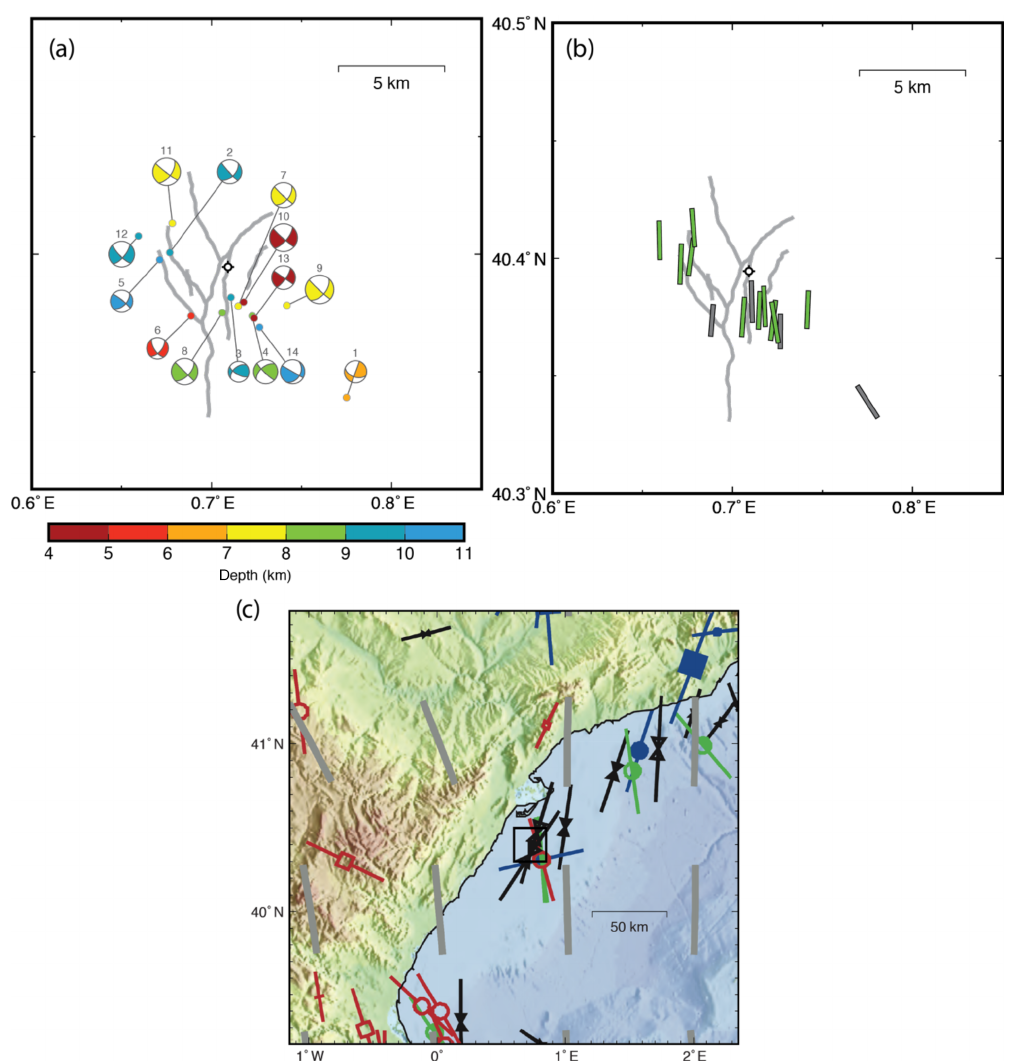
Figure 6. Focal mechanisms obtained in this study. (a) Nodal planes projected in the lower hemisphere of the focal sphere. Colored quadrants correspond to compression, and the color represents focal depth according to the legend. Numbers above each beach ball correspond to the solution listed in Table 3. Thick grey lines indicate the traces of main faults in the area at 1700m depth (Geostock, 2010). (b) Orientation of the P axes of the mechanisms shown in panel (a) . Green indicates predominantly strike-slip mechanism, and grey mixed type. (c) Stress measurements and mean S H max orientations in the region of the CASTOR UGS from the current update of World Stress Map (Heidbach et al., 2016). Grey bars are the mean S H max orientations on a 1 ◦ grid estimated with a 250km search radius and weighted by data quality and distance to the grid point. For other symbols see the legend in Heidbach et al.